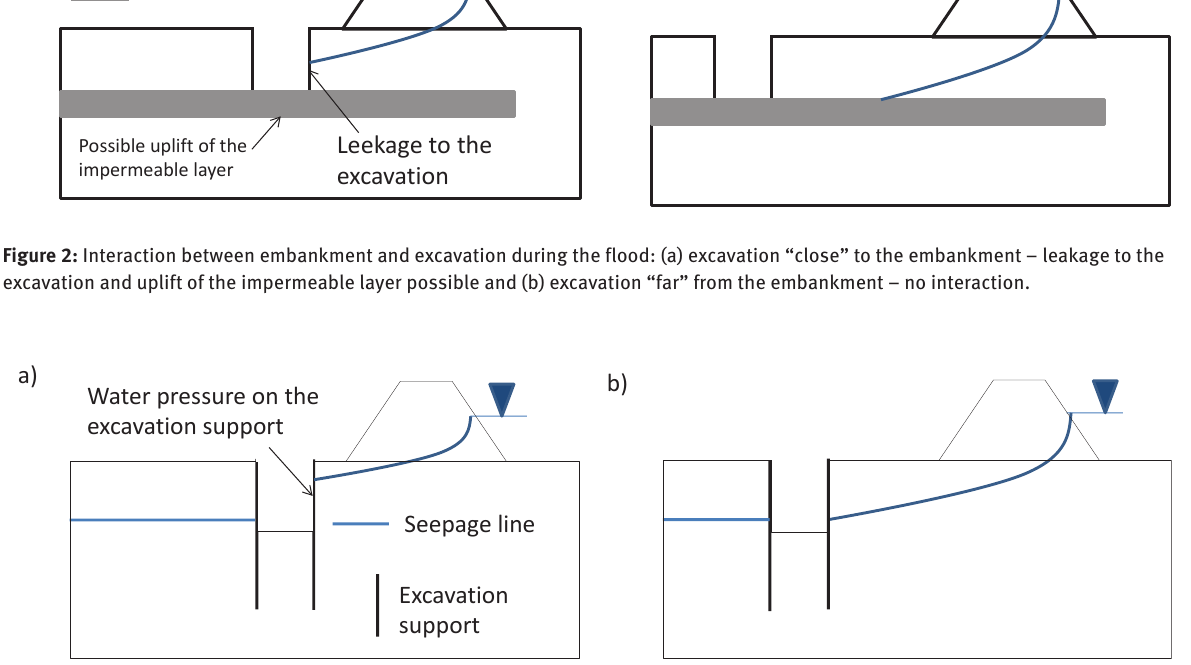
Figure 3: Interaction between embankment and excavation during the flood: (a) excavation “close” to the embankment – water pressure on excavation support, seepage line moves upward and (b) excavation “far” from the embankment – no